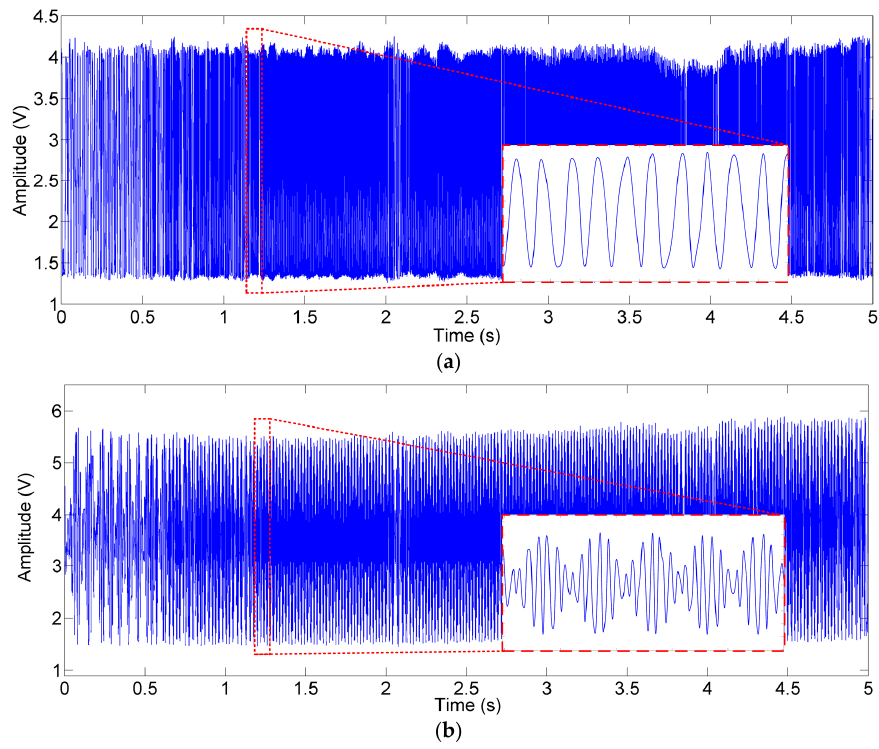
Figure 9. The interferogram signals in time domain: ( a ) the reference light and ( b ) the test light.